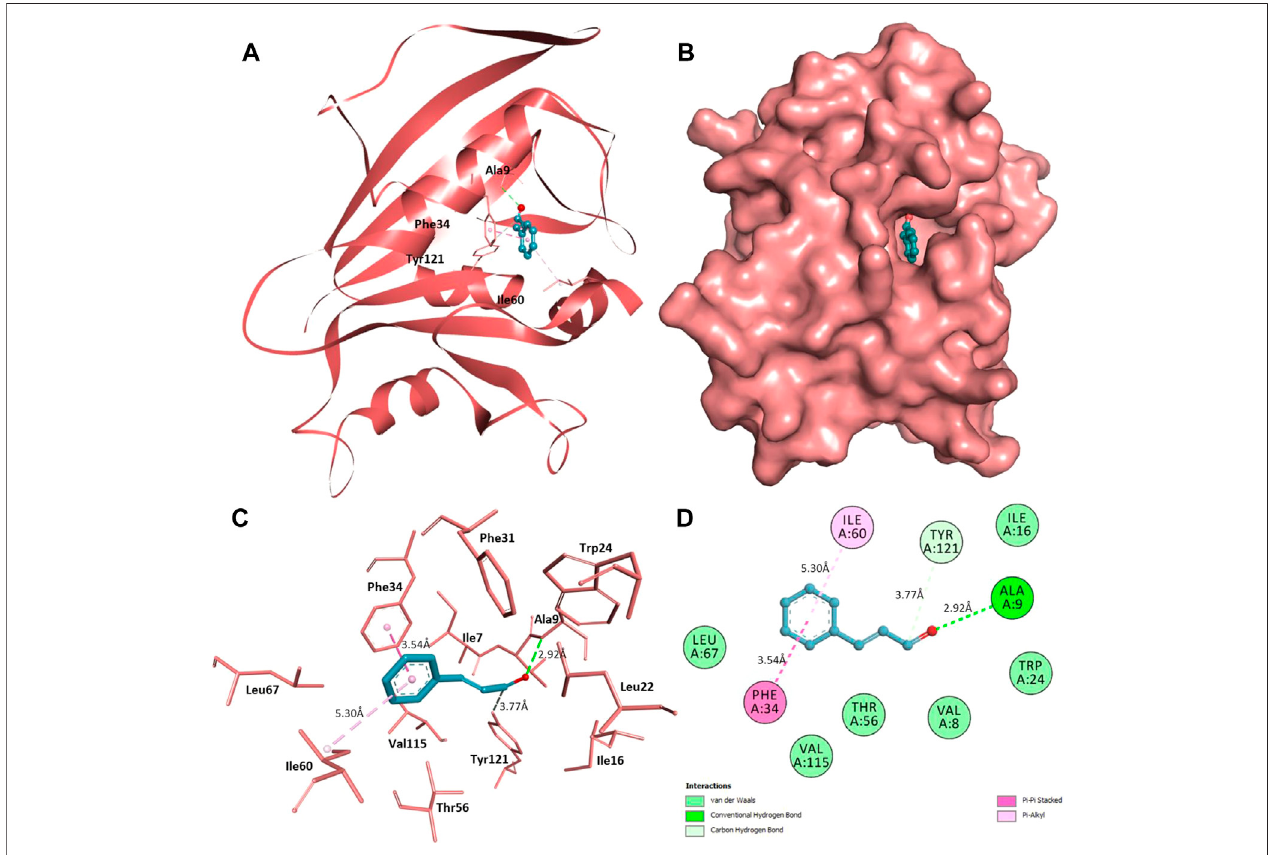
FIGURE 10 | Interaction of CIN to DHFR (A) Cartoon representation of DHFR in-complexed with CIN (B) Surface view of DHFR in-complexed with CIN (C) 3D representation of interacting residues of DHFR with CIN (D) 2D plot of interacting residues of DHFR with CIN.